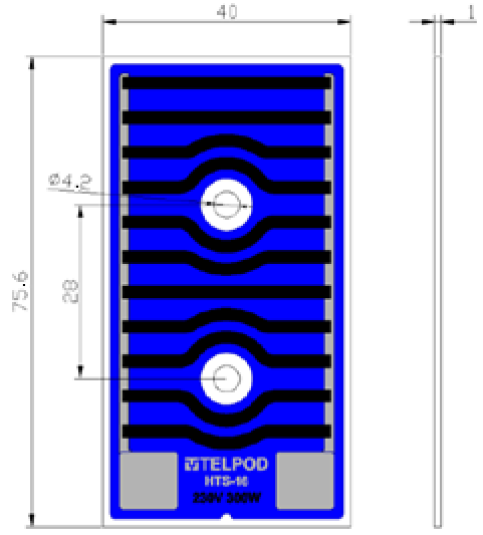
Figure 1. Telpod HTS-16-230-300-3/6.3 thick film heating element dimensions expressed in mm.